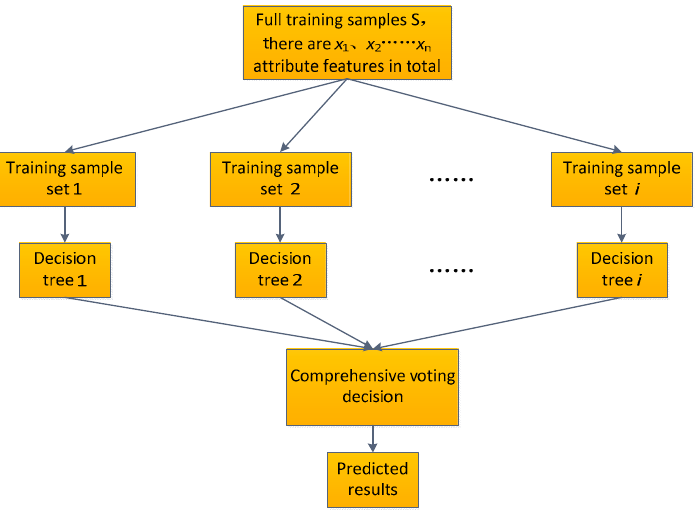
Figure 1. Flow chart of random forest algorithm.